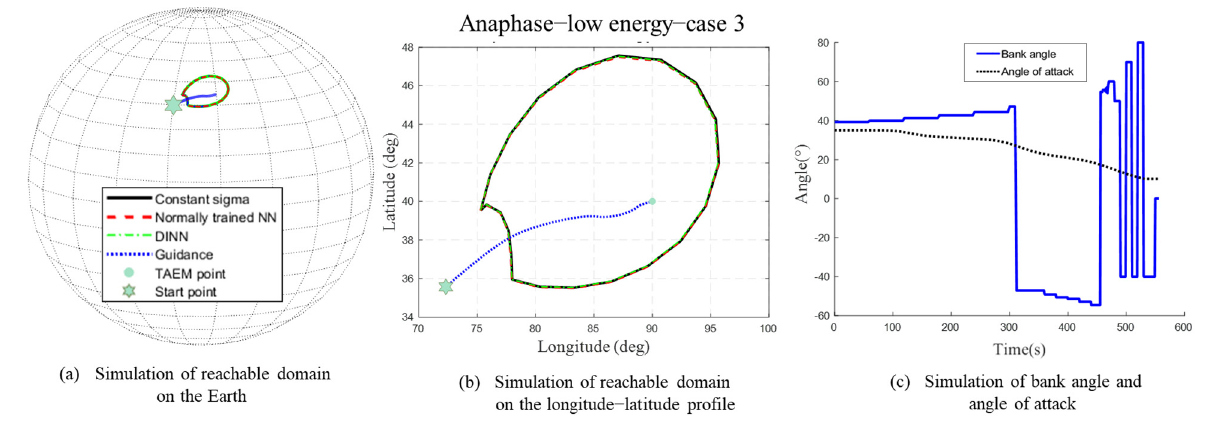
Figure 12. Simulation of low energy Case 3.